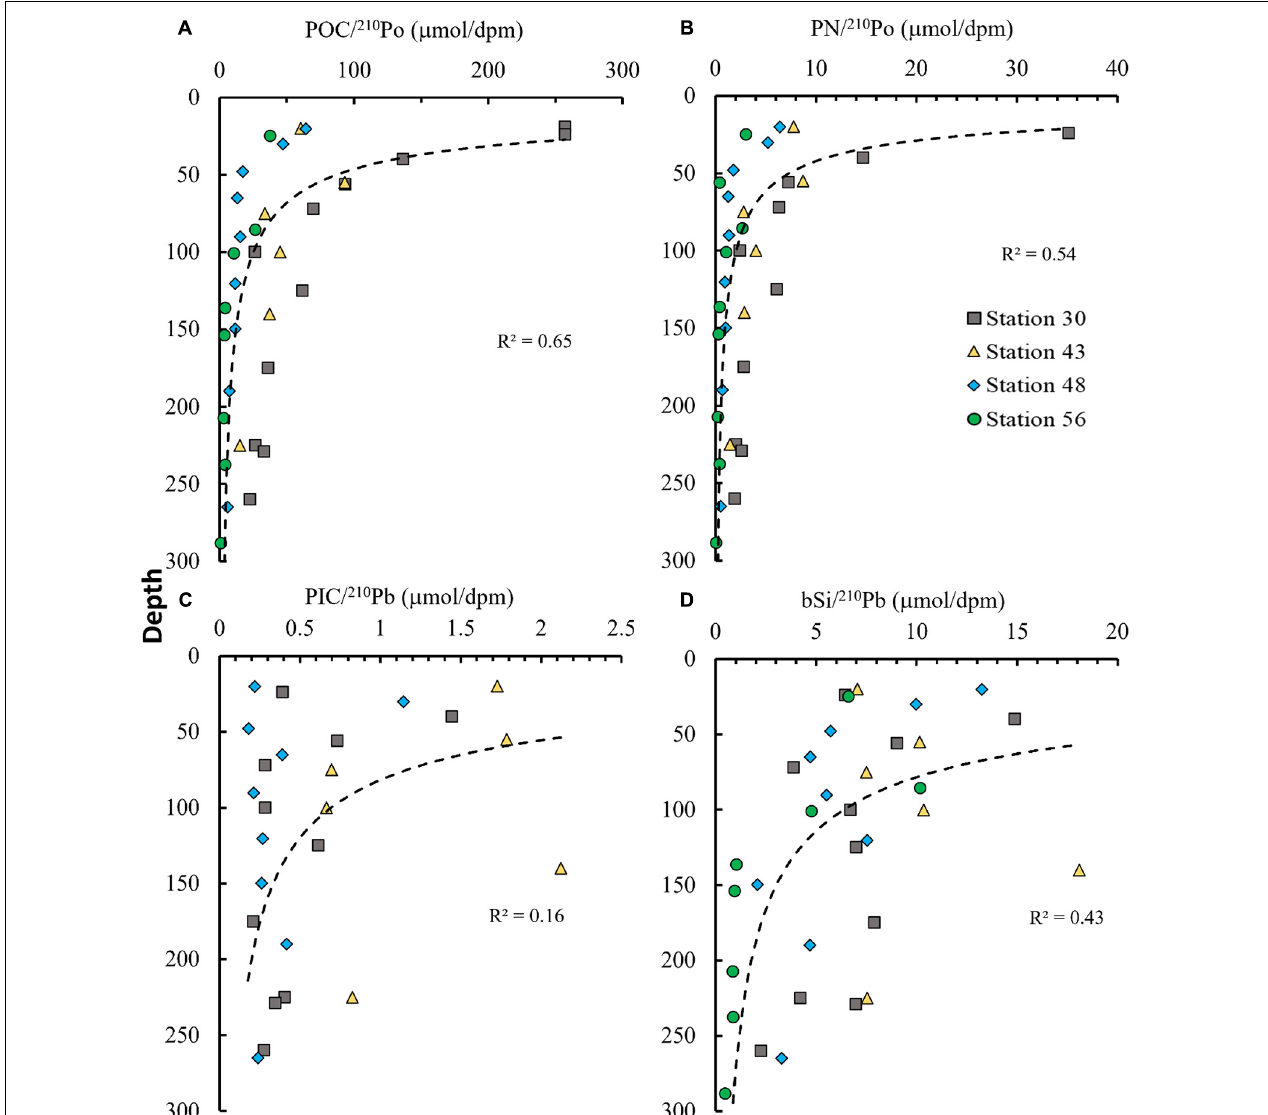
FIGURE 7 | The ratios of (A) POC/ 210 Po, (B) PN/ 210 Po, (C) PIC/ 210 Pb and (D) bSi/ 210 Pb in the large particulate samples for upper 300 m water column depth. The dashed black line represents the power function fitted using the samples collected in upper 300 m depth.